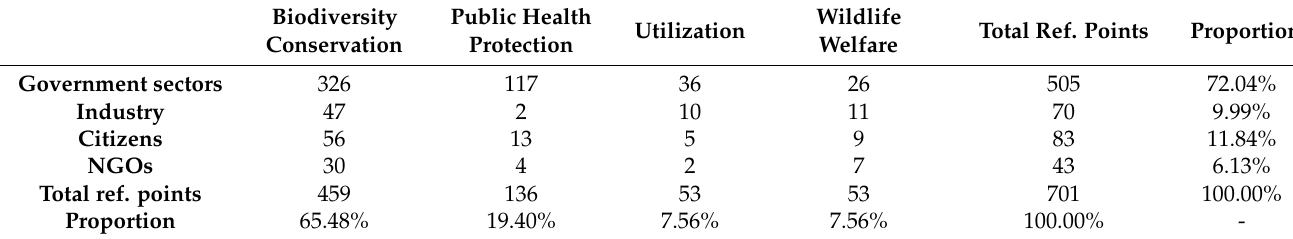
Table 4. Matrix Coding of Policy Subjects and Policy